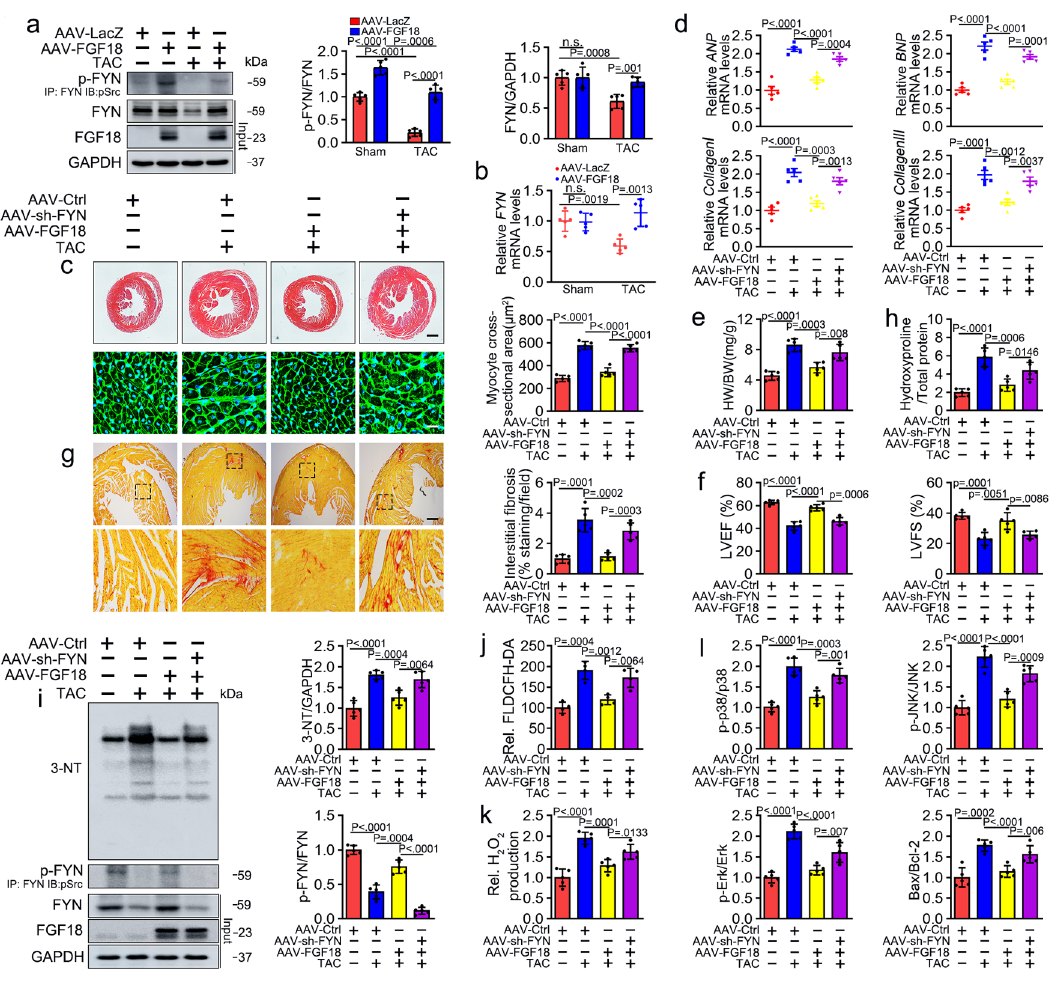
Fig. 6 | Loss of FYN abolishes the cardioprotective effects of FGF18 in vivo. a , b The mice were injected with AAV9-LacZ or AAV9-cTnT-FGF18 intravenously before Sham or TAC operation. a Western blotting with p-FYN (IP: FYN, IB: p-Src) and FYN antibody. Quanti fi cation of relative FYN activity and protein expression levels (right panel). n =5. Data represent means±SD. one-way ANOVA with Tukey multiple comparisons test. b qRT-PCR analysis of FYN levels. n =5. Data represent means±SD. one-way ANOVA with Tukey multiple comparisons test: n.s. = not signi fi cant. c – i AAV9-cTnT-FGF18 and control vector were injected intravenously into tail veins of 6 weeks old male C57BL/6J mice, respectively. One week after the injection, these mice were intravenously injected with the adeno-associated virus (AAV9-cTnT-sh-FYN; AAV9-Scramble) into tail veins. One week after the injection, these mice were subjected to Sham or TAC operation for 6 weeks. c Histological analyses of the HE staining and WGA staining ( n =5. Scale bar=0.6mm for upper HE staining; scale bar=20 μ m for lower WGA staining). Statistical results for the